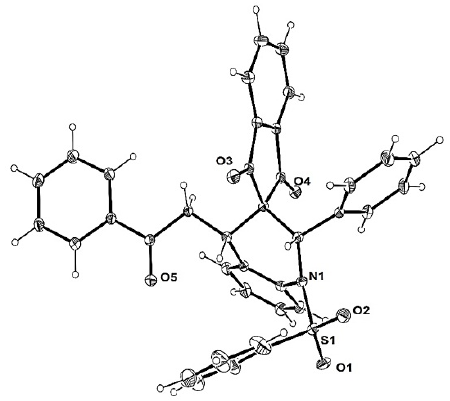
Figure 1. The single crystal X-ray diffraction of 3a .